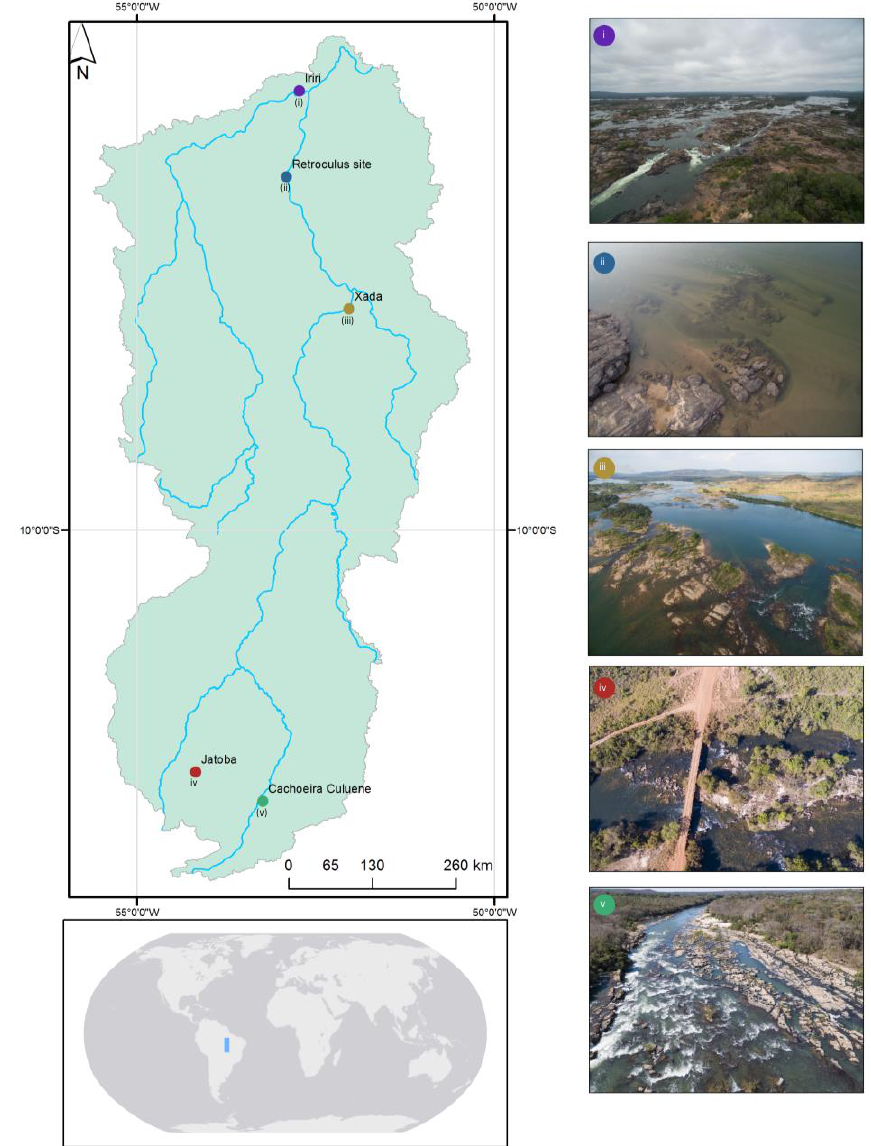
Figure 1. Study sites in the Xingu River basin, Brazil. Service layer credits: ESRI, HERE, Garmin, OpenStreetMap contributors and the GIS community.